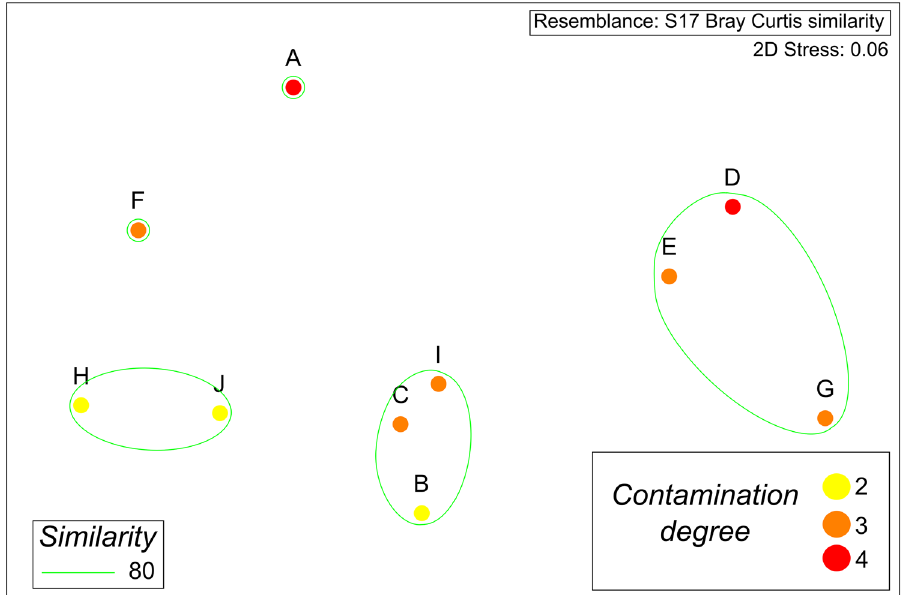
Figure 6. Nonmetric multidimensional scaling (MDS) ordination used to represent the urban sinkholes in study in terms of the concentration of heavy metals in the